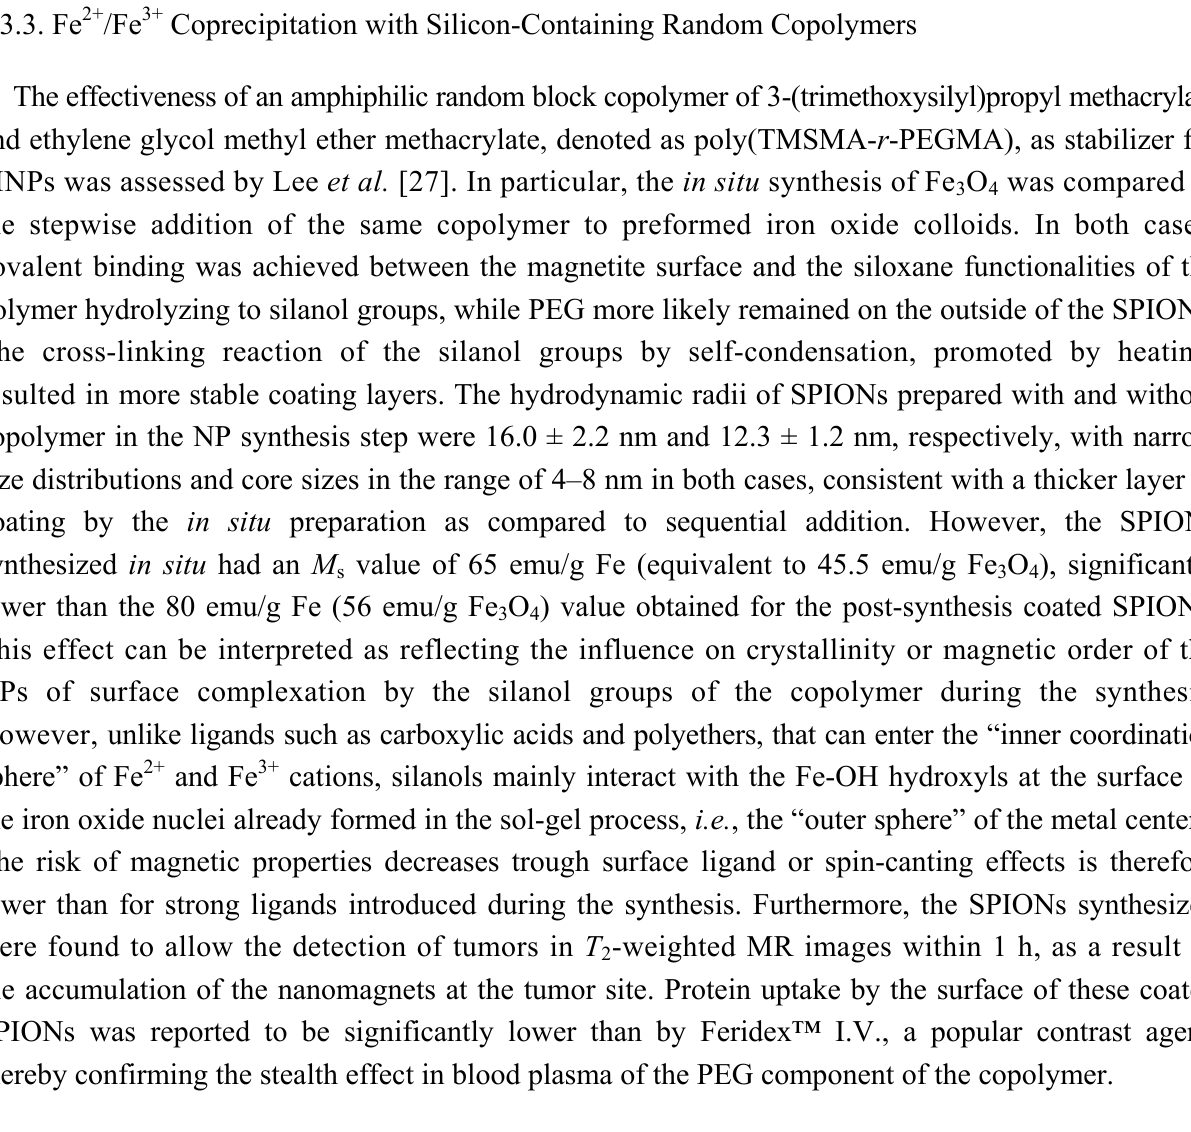
O NPs loaded with 3 4